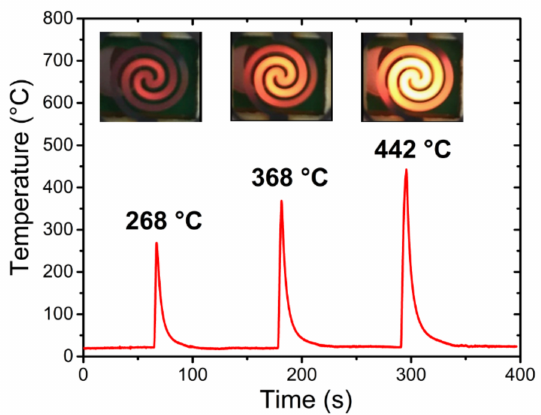
Figure 5. Heating intensity of the PreHG, both visually and by ◦ C intensity, for the three heating times (2, 3 and 5 s).